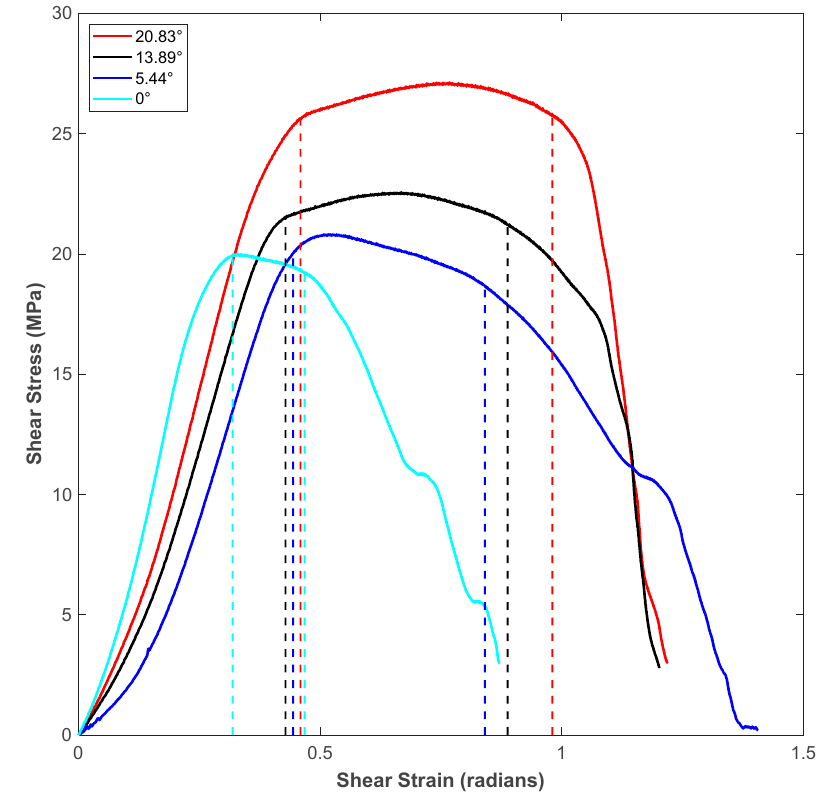
Figure 5. Shear stress-strain response for specimens of different shear angles for Vertical raster ori- entation.